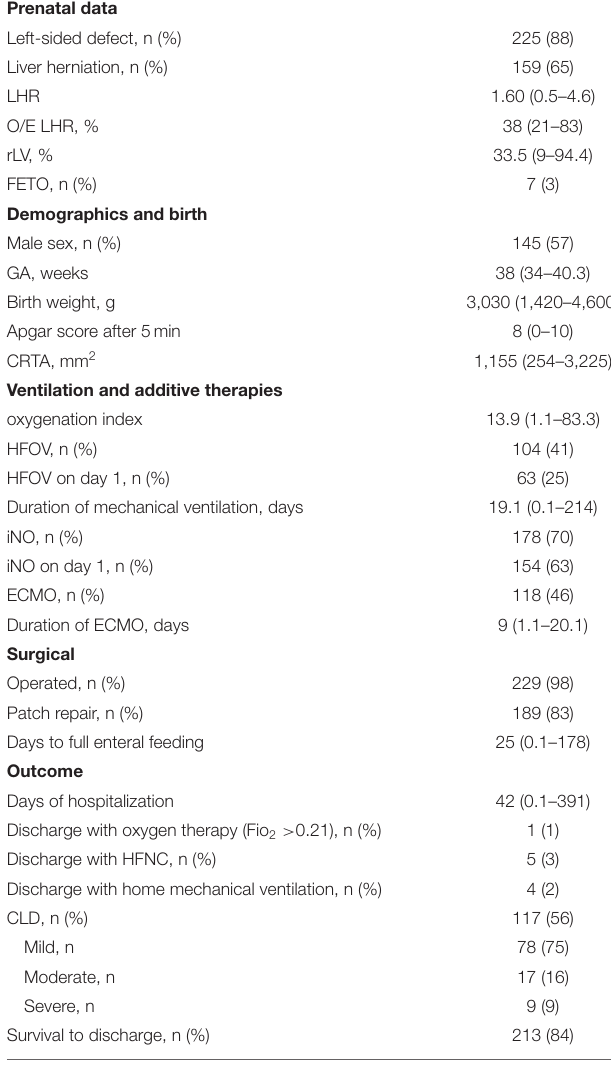
TABLE 1 | Patient characteristic of the study population ( n =